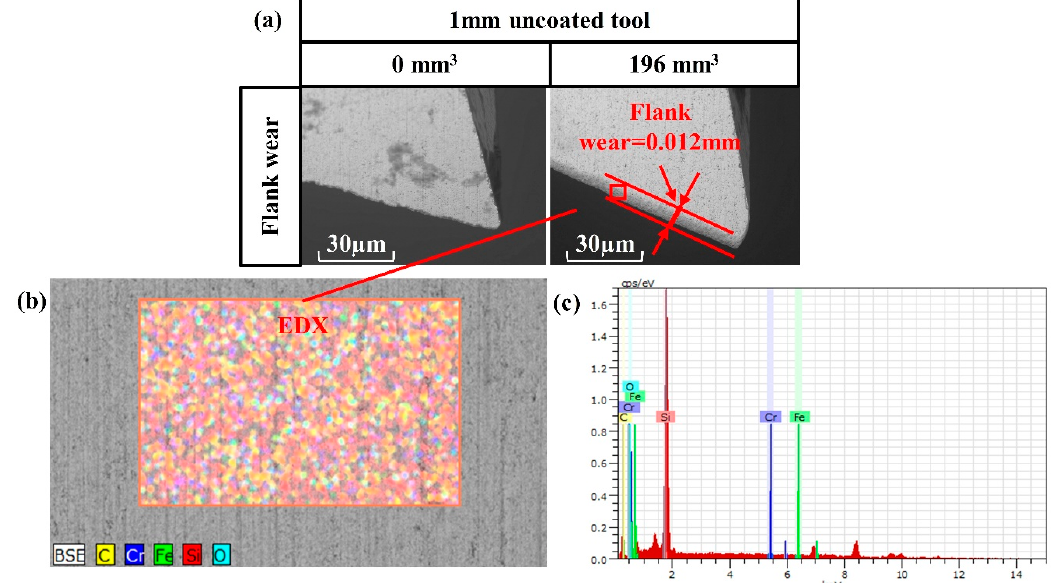
Figure 14. Tool wear: ( a ) SEM micrographs of the tool wear; ( b , c ) energy dispersive X-ray spectroscopy (EDX) analysis of the cutting edge.